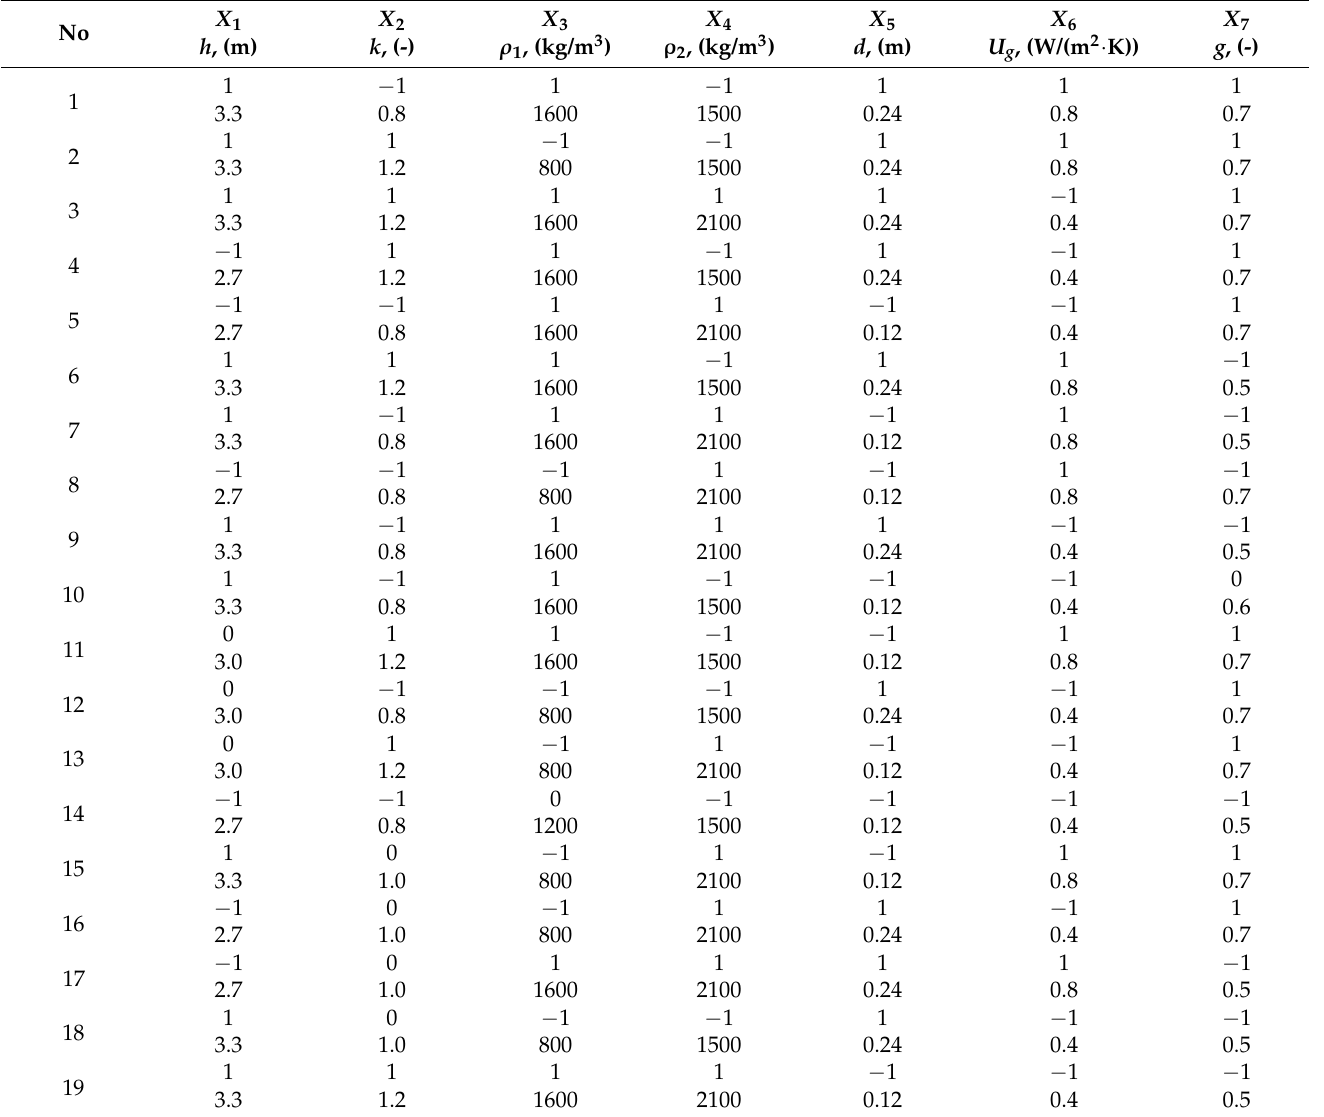
Table 1. Design of a computational experiment for seven variables for N = 40 trials, where h , k , ρ 1 , ρ 2 , d , U g , and g are natural factors, while X 1 , X 2 , X 3 , X 4 , X 5 , X 6 , and X 7 are coded